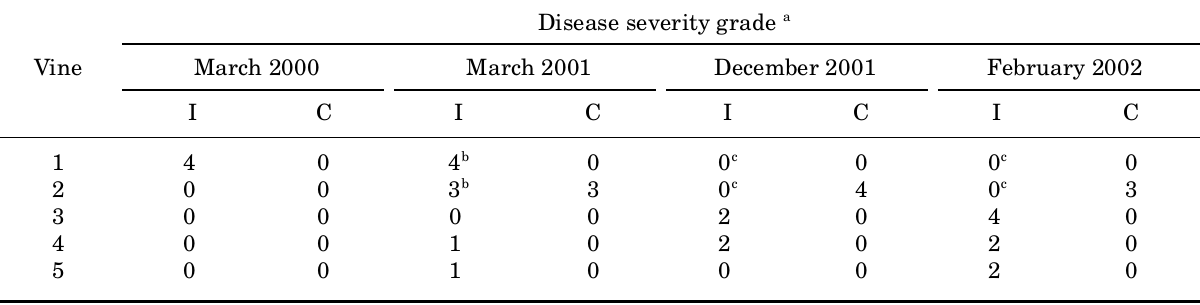
Table 1. Pathogenicity test with the basidiomycete species isolated from hoja de malvón affected vines (strain Fl 1514). Severity of symptoms on inoculated (I) and control (C) vines.